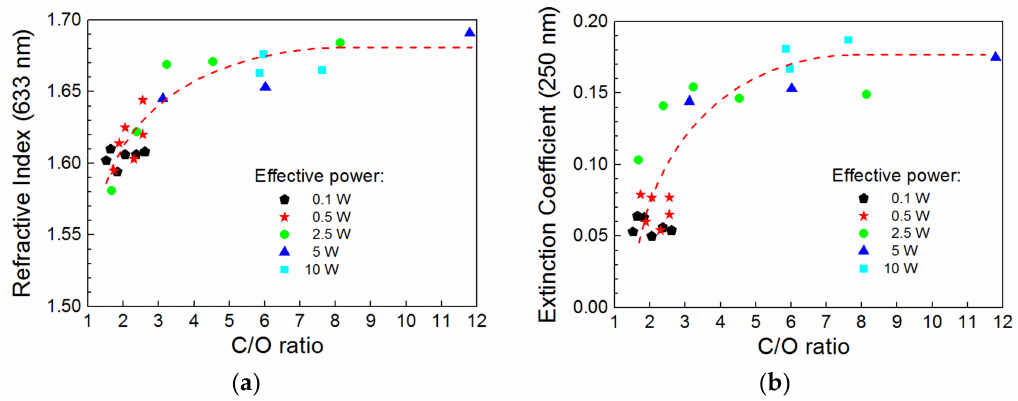
Figure 8. ( a ) refractive index (633 nm) and ( b ) extinction coefficient (250 nm) correlated with the C/O ratio for oxidized plasma polymer films deposited at different effective